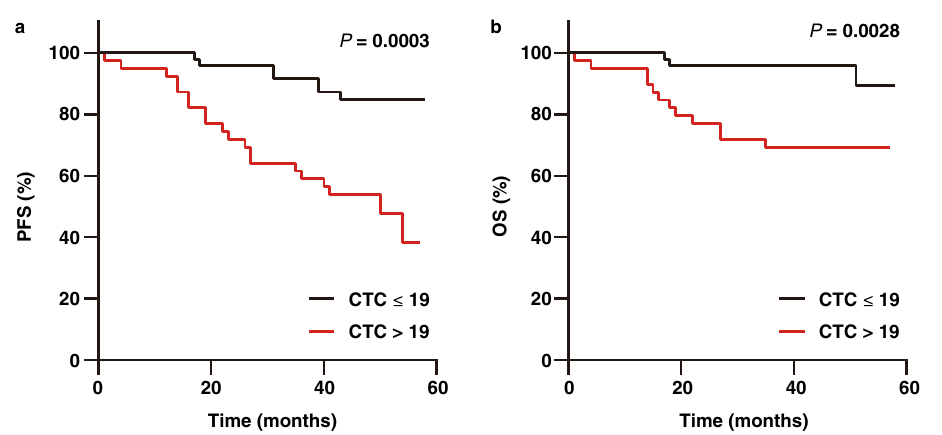
Figure 5. Kaplan–Meier curves showing estimated PFS ( a ) and OS ( b ) for patients with CTC positivity (CTC > 19) and CTC negativity (CTC ≤ 19) at the end-point follow-up